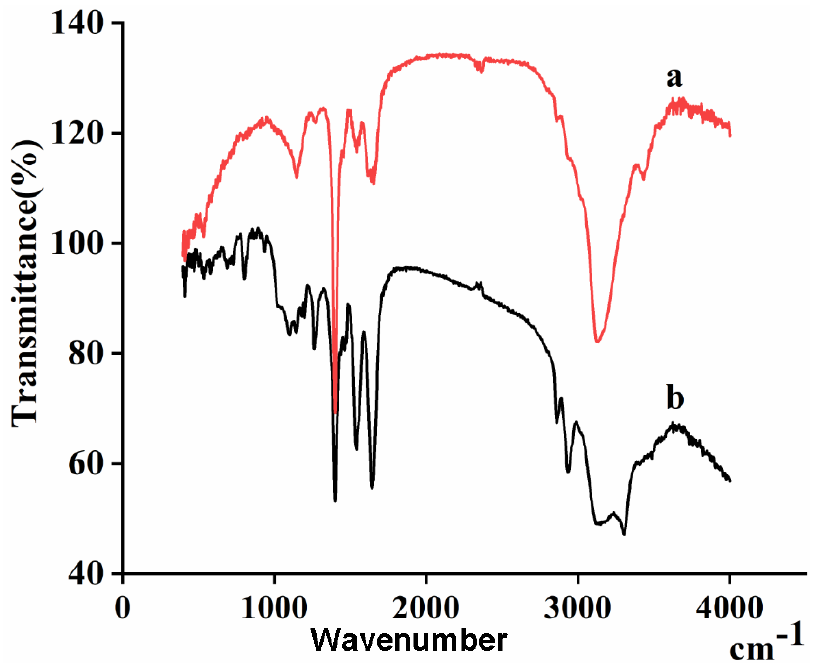
Figure 6. Infrared spectra of (a) nylon6 nanofiber membranes and (b) nylon6/pig nail keratin composite nanofiber membranes.